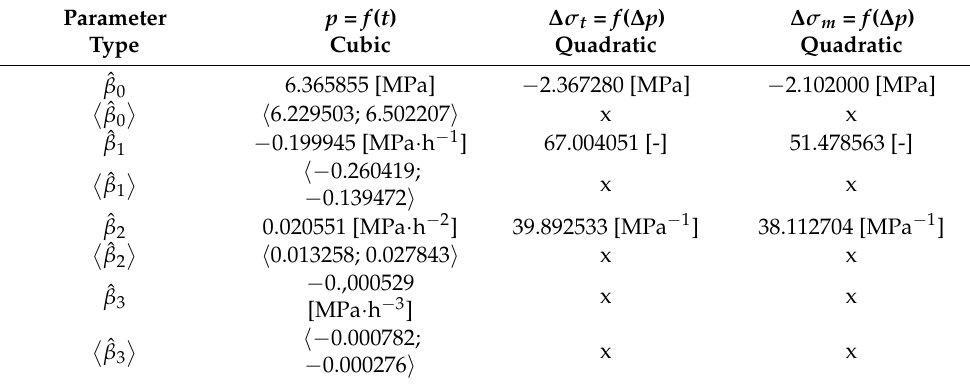
Table 2. Parameters of applied polynomial models of the second and third degree of individual regression